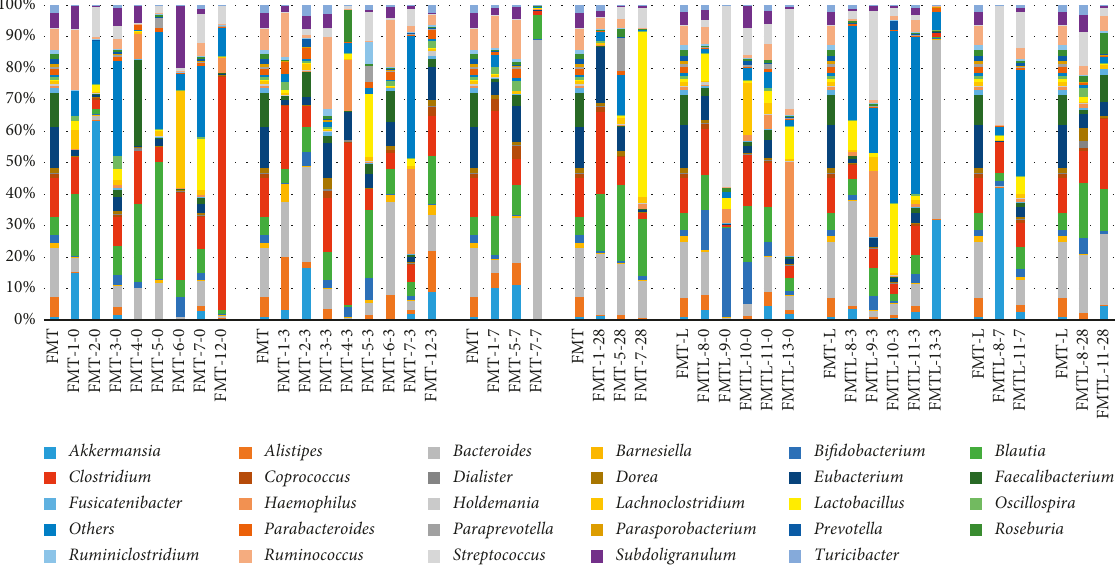
Figure 2: Average bacterial composition at the genera level. Distribution of bacterial genera in the fecal microbiota transplant (FMT) group and the Lactobacillus -FMT (L-FMT) group. The label of each sample (e.g., FMT-5-0) denotes treatment (FMT or L-FMT), the assigned number of each patient, and days on treatment (0 To facilitate comparison and visualization, the distribution of bacterial families of the donors is presented for the FMTgroup and the L-FMT